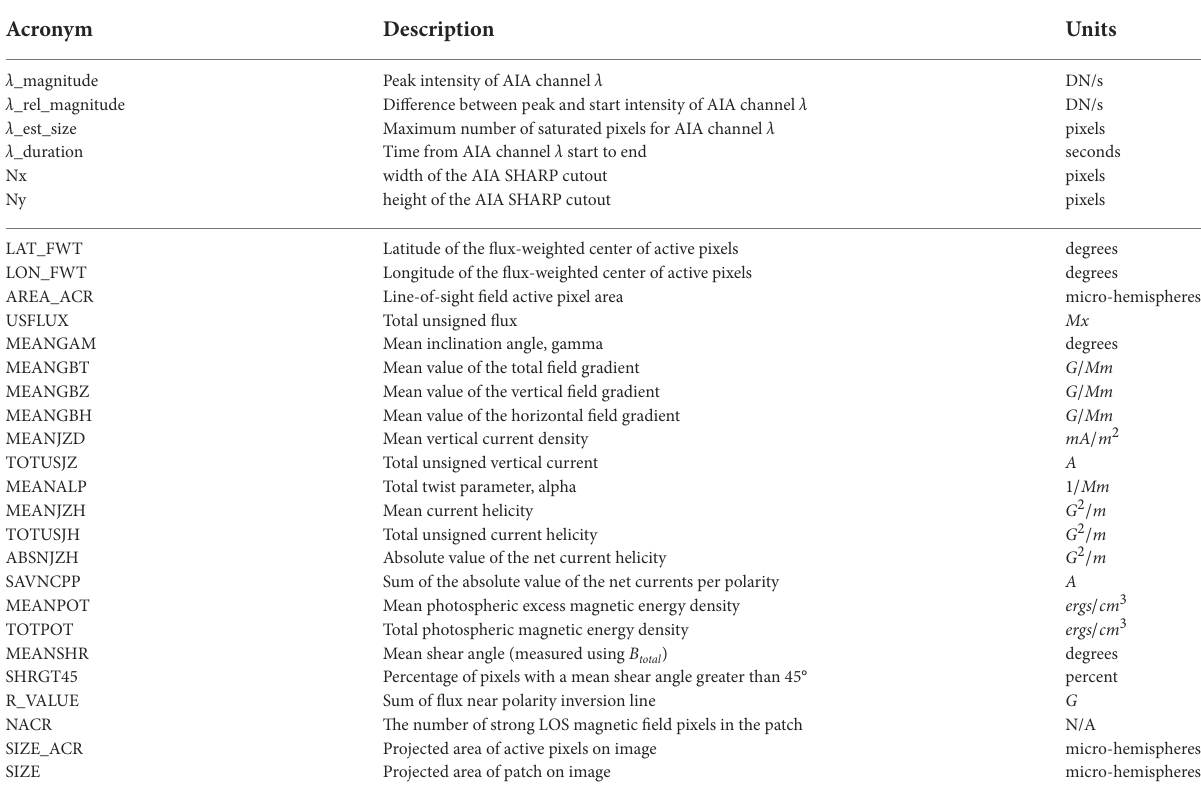
TABLE 3 AIAandHMISHARPbasedfeaturesfortheERTmodel.ForAIAbasedfeatureswithchannel λ ,weconsiderall6wavelengths ( λ = 94 Å , 131 Å , 171 Å , 304 Å , 193 Å , 1600 Å ) .